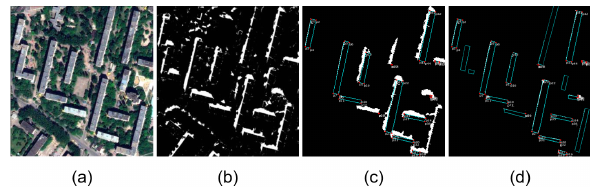
Figure 3. The implementation of the developed algorithm for architectural documentation. First test image, (a) Geoeye-1 pan-sharped image (RGB), (b) the extracted shadow regions before removing the small unwanted areas (here, we provided two cases to present the binary image of the detected shadow regions with and without the existence of unwanted areas), (c) the extraction of the building geometry, (d) the location and shape of the detected buildings